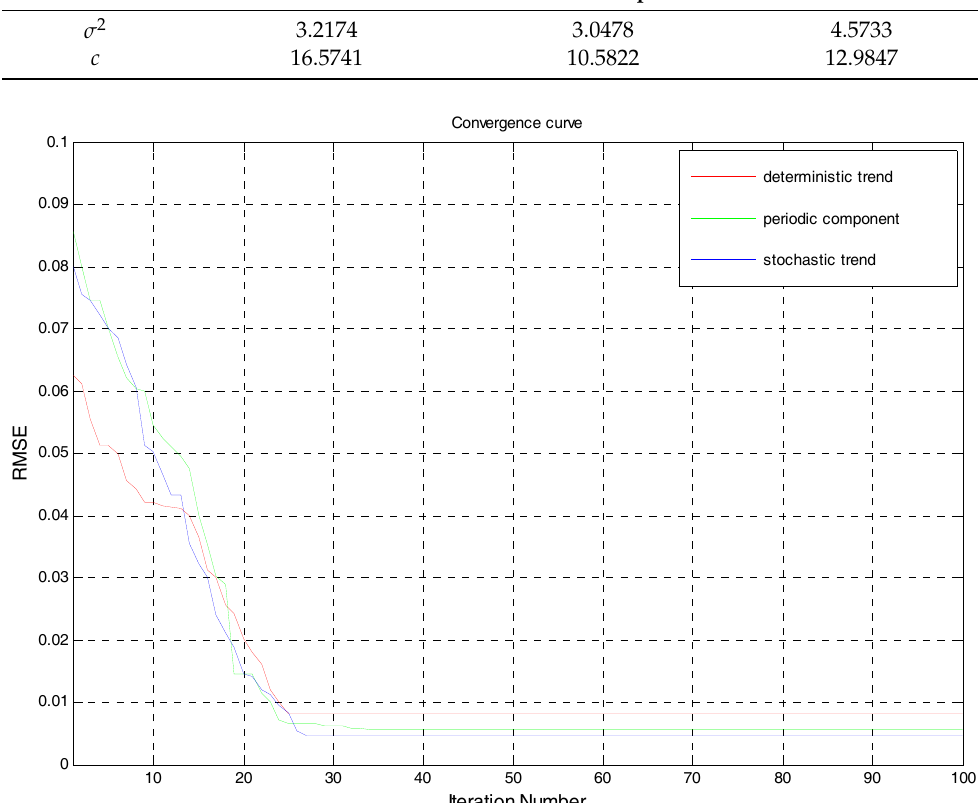
Table 2. The optimal values of σ 2 and c .